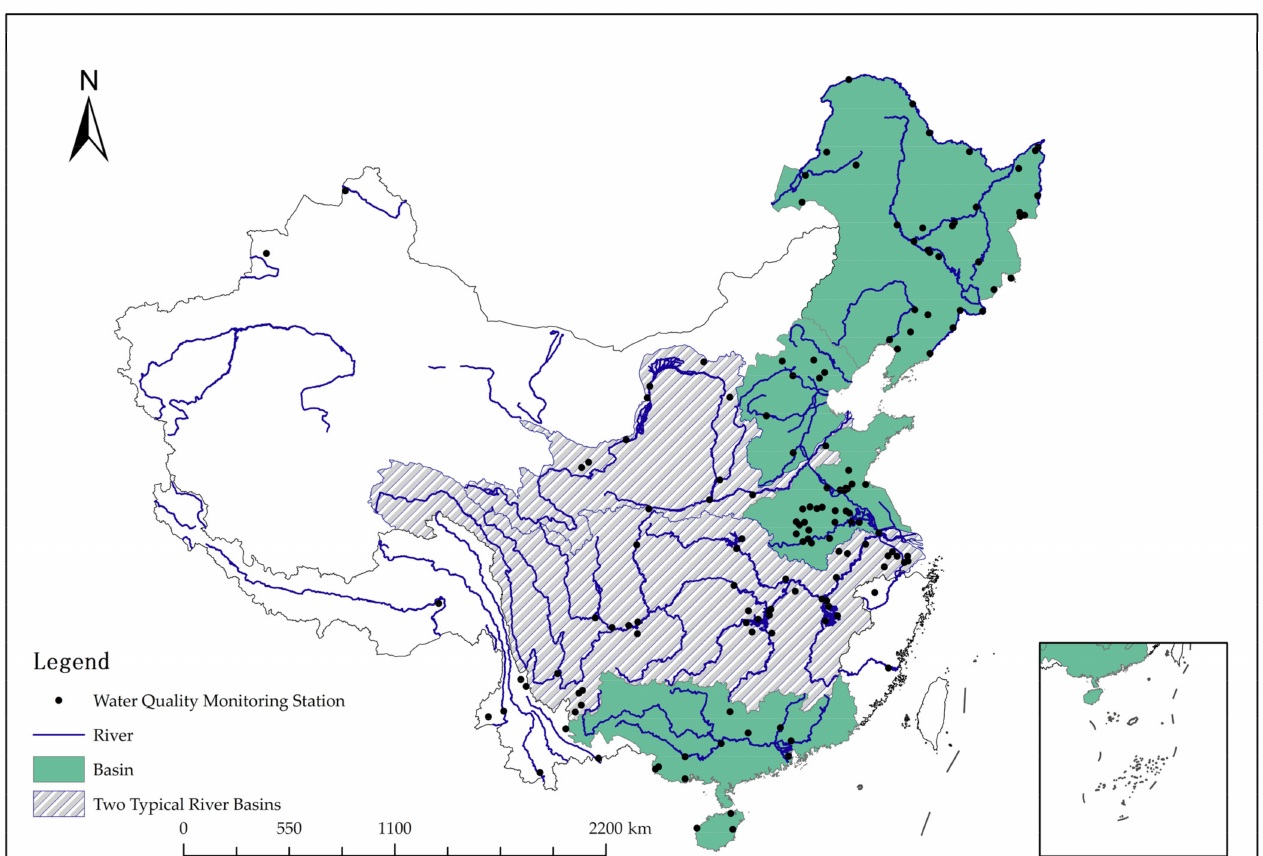
Figure 2. Map of seven major river basins and water quality monitoring stations in China. (Note: The shaded area represents the Yangtze River Basin and the Yellow River Basin, and the green shapes represent the total area of the other five